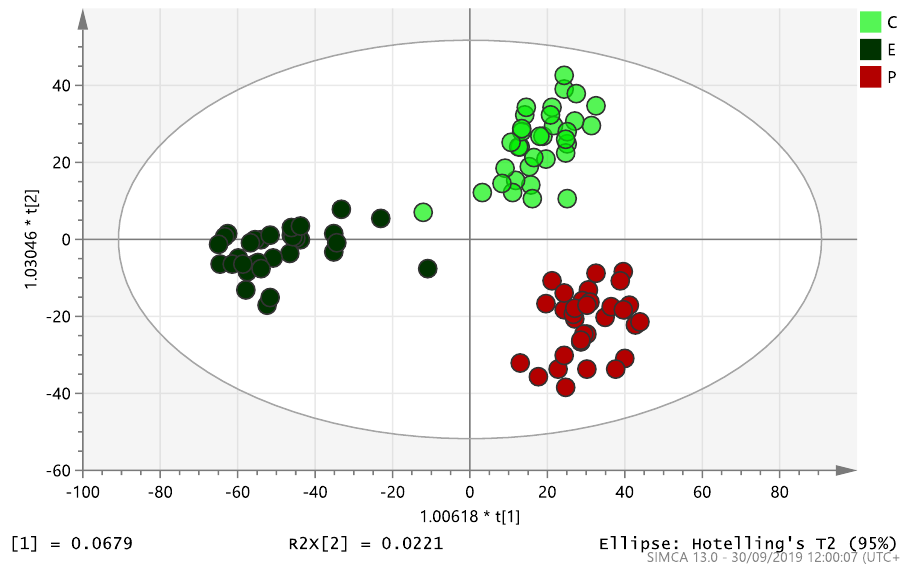
Figure 1. Multivariate analysis based on all detected ions from endometrial tissue samples: OPLS-DA score plot of control (C, n = 34), endometrial cancer (E, n = 34) and PCOS (P, n = 34). R2X(cum) = 0.286 and Q2(cum) = 0.514.